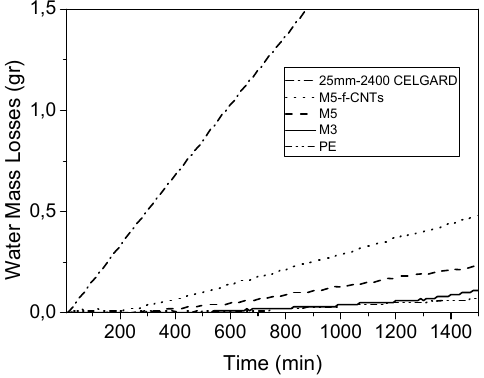
Figure 7. Typical curves of water mass losses as a function of the tested time.